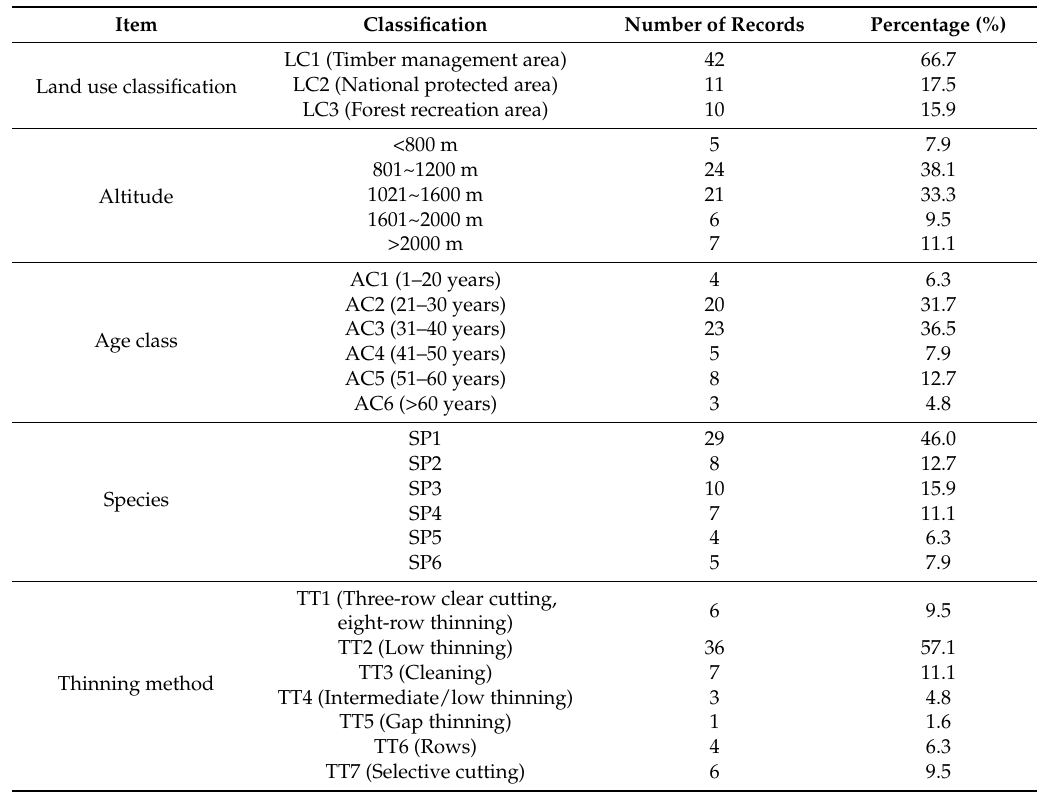
Table 1. Attributes of research sites.